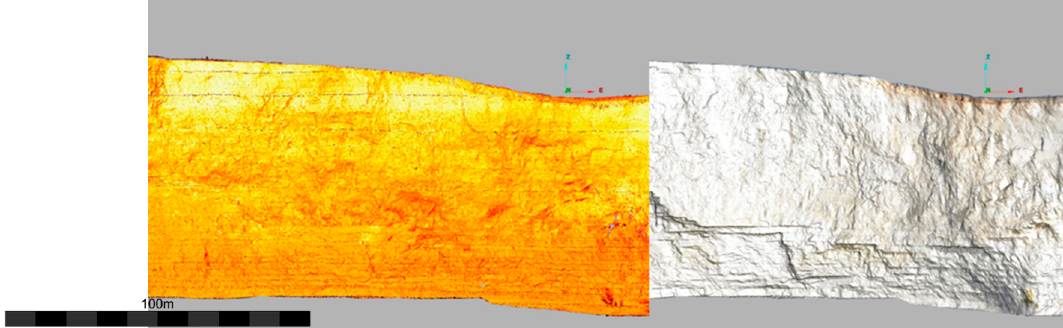
Figure 19. Intensity and RGB color scans of a section of the Seven Sisters cliff.